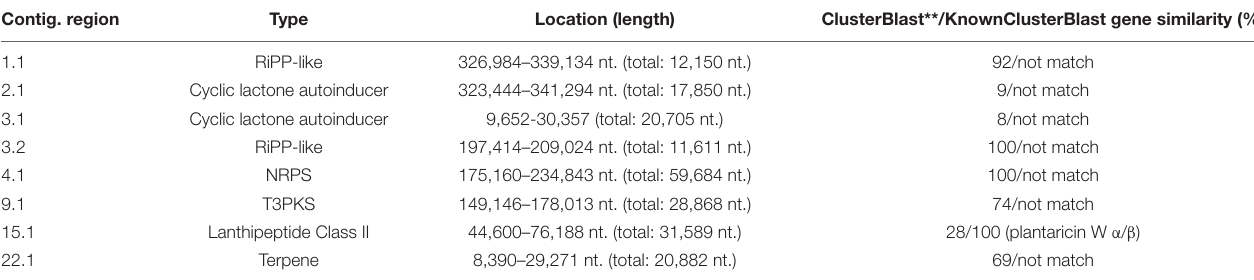
TABLE 3 | Identified secondary metabolite biosynthetic gene clusters with antiSMASH using strictness “strict”*. Contig. region